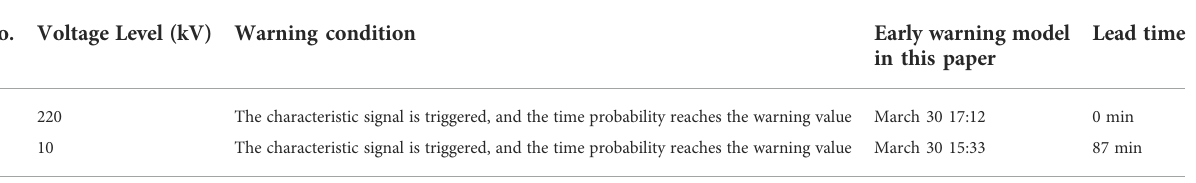
TABLE 9 Warning